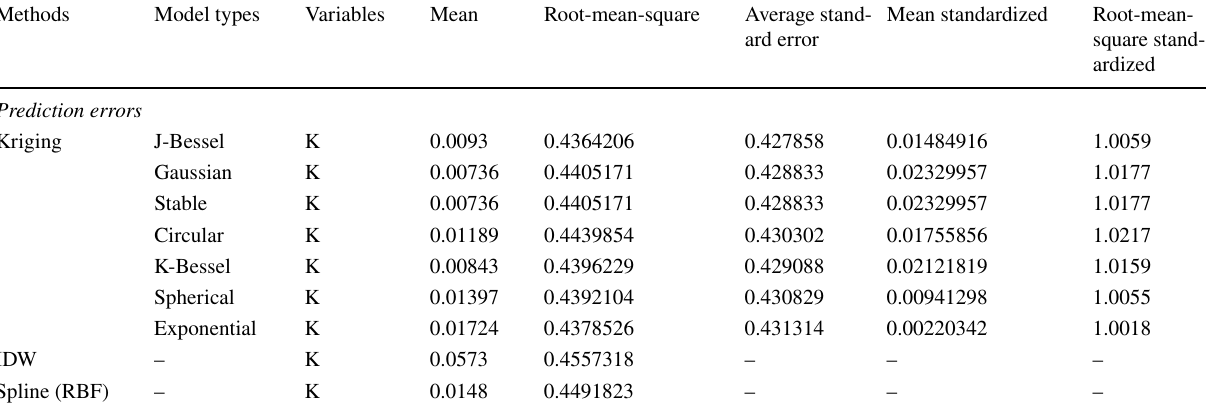
Fig. 6 Spatial distribution map of irrigation water quality index (IWQI) Table 7 Cross-validation result for potassium